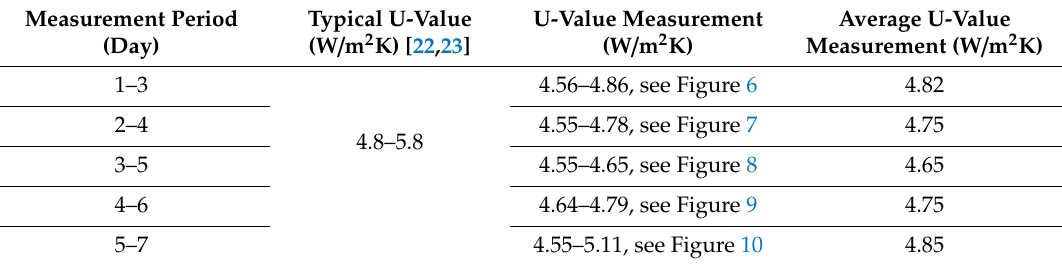
Table 1. Summary of the thermal transmittance